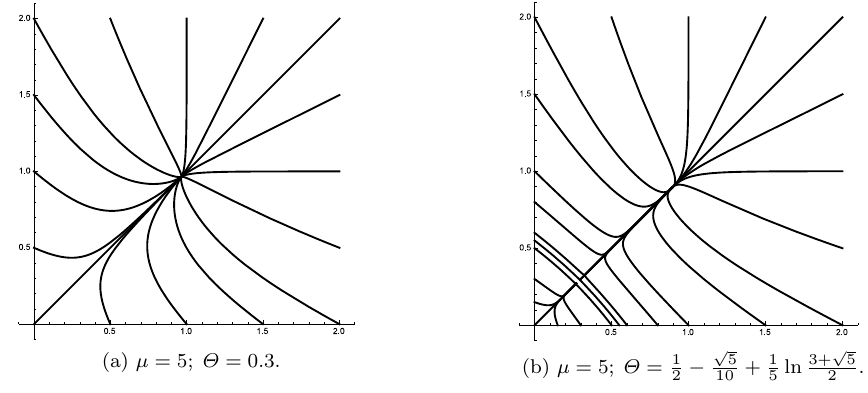
Figure 7. The phase portraits with different